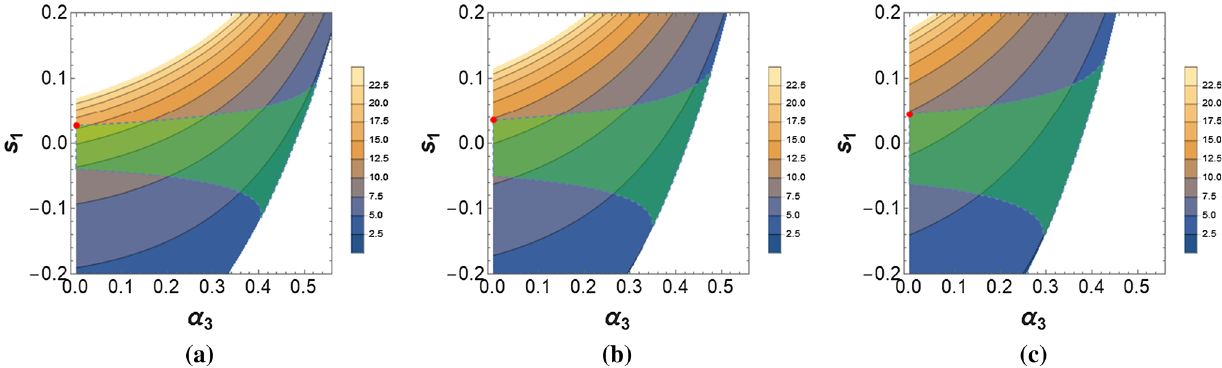
a When b = 0, E 3 max ≈ 15 . 6350; b when b = 0 . 1, E 3 max ≈ 12 . 2977; c when b = 0 . 2, E 3 max ≈ 9 .